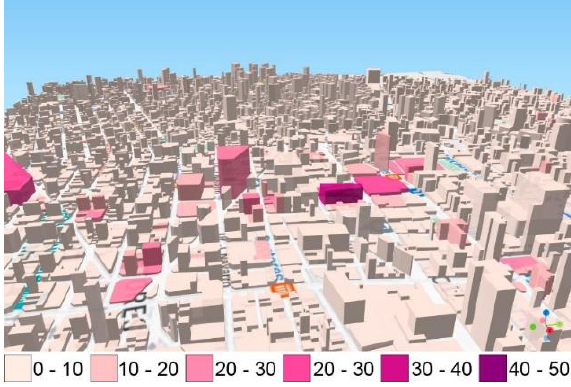
Figure 5. 3D model hotspots using the Mexico City model.